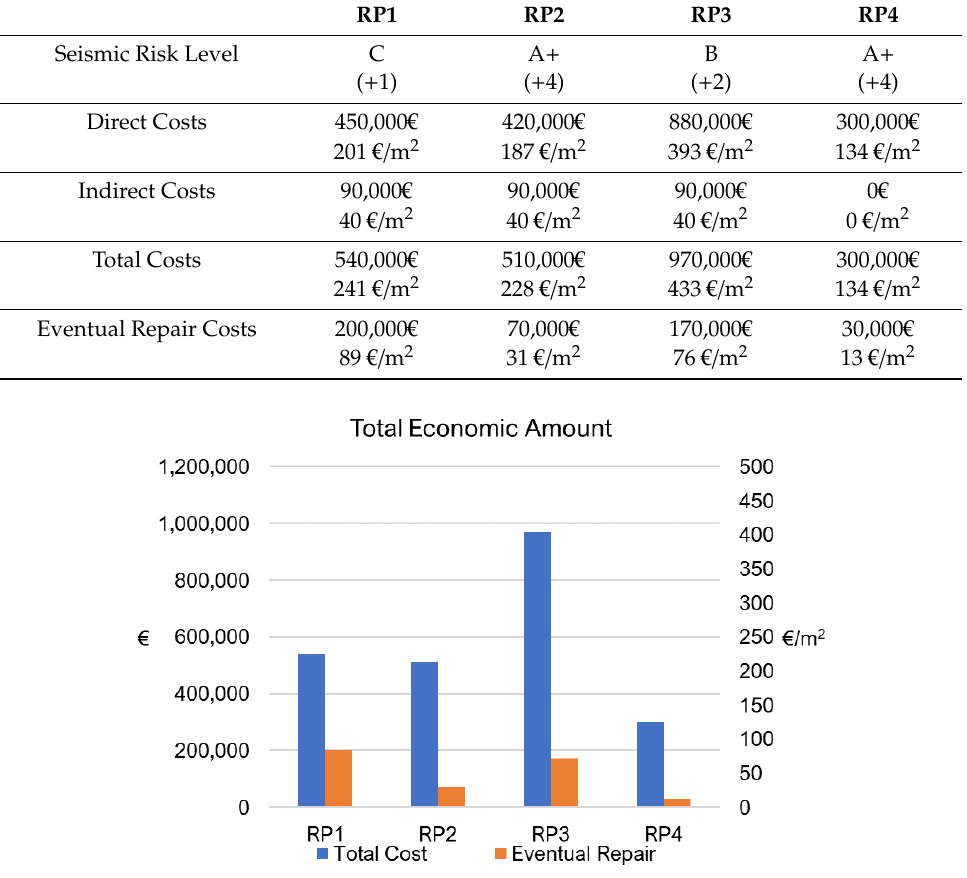
Figure 27. Total and per unit surface costs for di ff erent